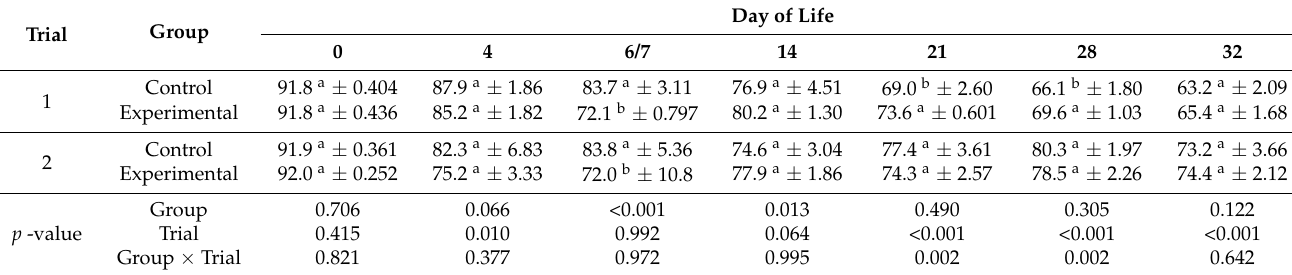
Table 3. Dry matter content (%) of litter depending on different groups and different trials ( n = 18 each, except at d 0 and d 4; n = 6) using two-factorial